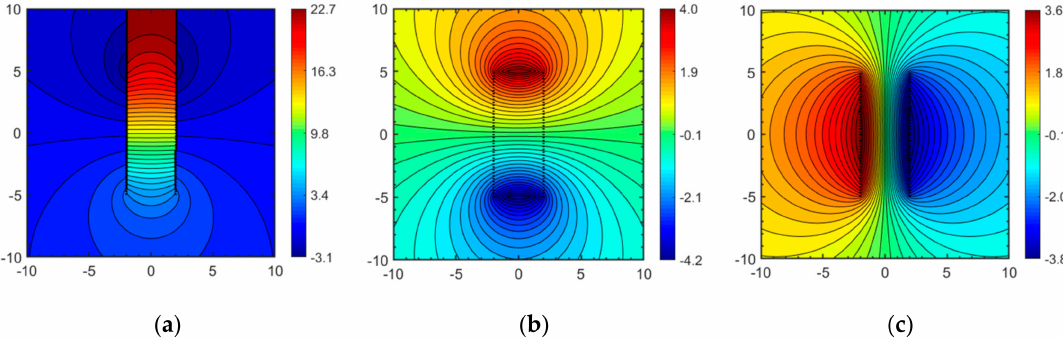
Figure 15. Areal doublet (enhanced permeability flow channel). ( a ) Potential function solution and isobars ( Φ ) with MATLAB branch cuts, ( b ) Potential function solution applying manual separation of real part of complex potential applying method of Appendix A. ( c ) Streamlines and stream function solution ( Ψ ) (rainbow colors). Strength of the areal doublet is ( υ ) = 100 m 4 · s − 1 and z c =